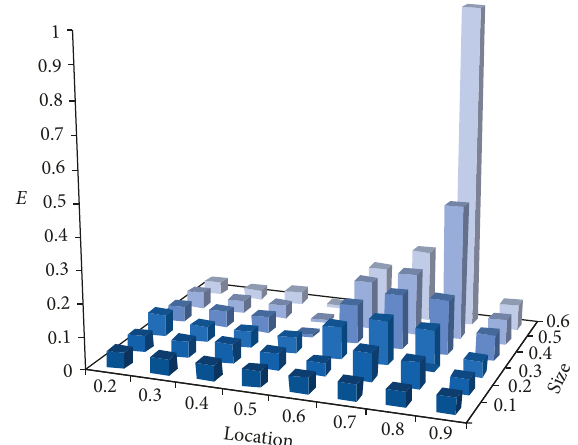
Figure 12: Damage index for the second crack of a multicracked [1386] composite beam using 5 modes with measured error ranging from 2 to 3%.